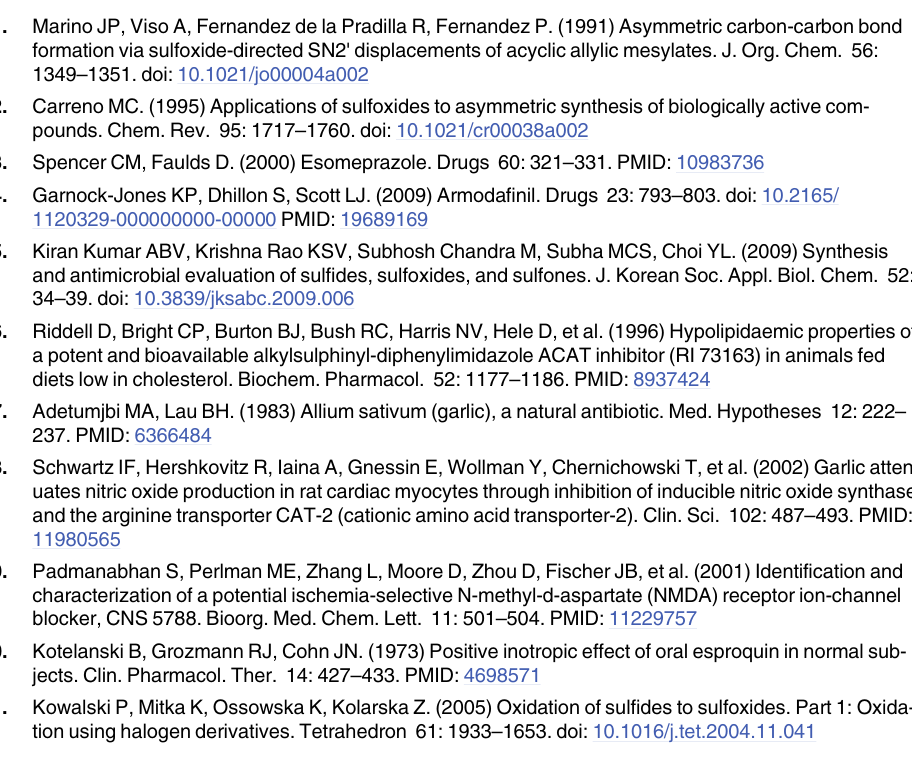
O (4 mM). Controls were performed using 2 2